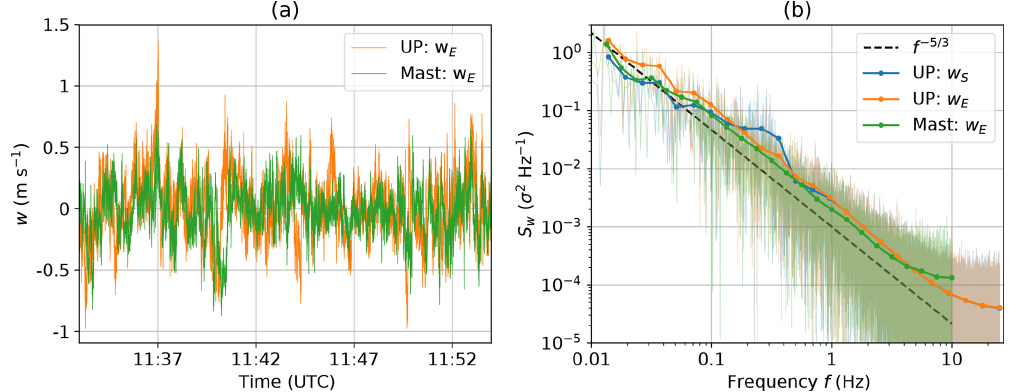
Figure 5. Time series of the vertical wind velocity w (a) and power spectral density S w (b) . Wind velocities are shown for the UP mea- surements with (orange) and without motion correction (blue, only plotted in panel b ). As reference, the sonic data measured on the mast at a height of 10m are presented (green). The time period is the same as in Fig. 4; the mean horizontal wind velocity for this period was 1.7ms − 1